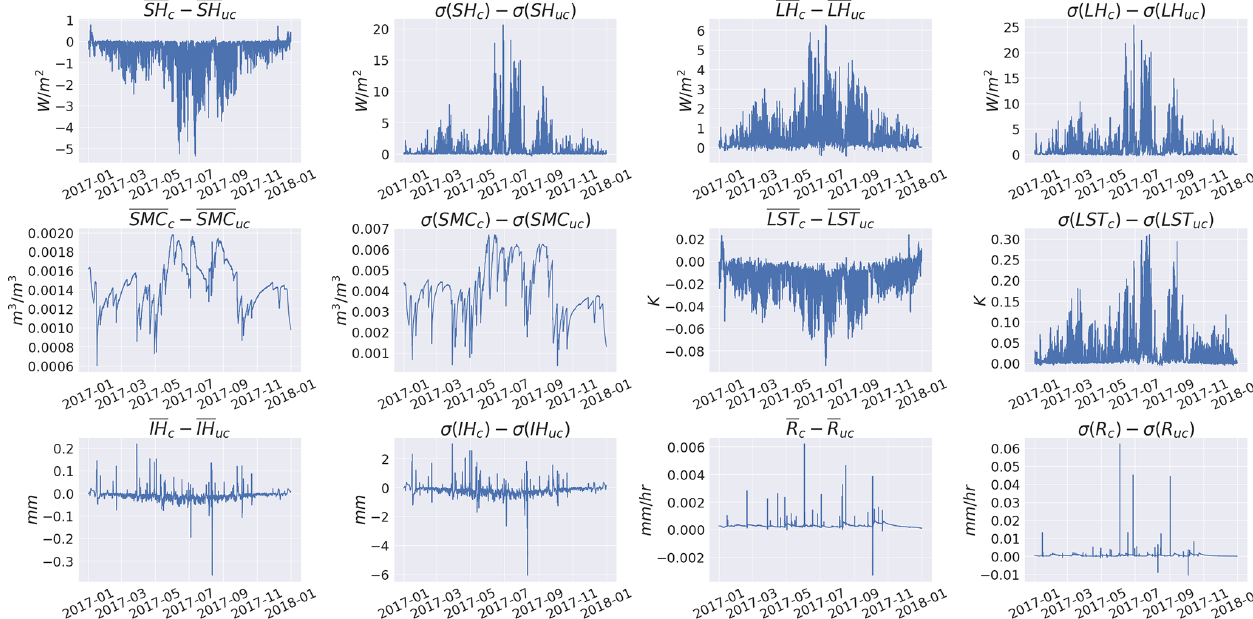
Figure 8. Temporal differences between the coupled and uncoupled simulations between 1 January 2017 and 31 December 2018. The explored variables include the spatial mean ( X ) and spatial standard deviation ( σ(X) ) of sensible heat flux (SH), latent heat flux (LH), root zone soil moisture (SMC), land surface temperature (LST), runoff ( R ), and inundation height